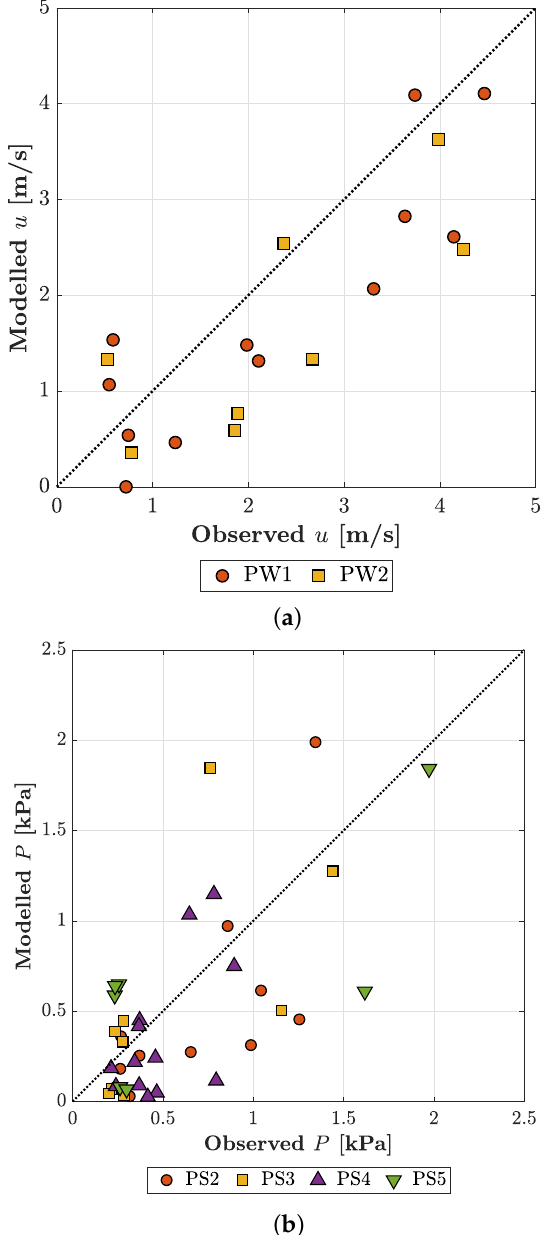
Figure 10. ( a ) Modelled against observed peak flow velocity u [m/s] per overtopping wave during t = 170–350s in Test B using α = 500 and β = 2.0. ( b ) Modelled against observed peak pressure P [kPa] per overtopping wave during t = 170–350s in Test B using α = 500 and β =